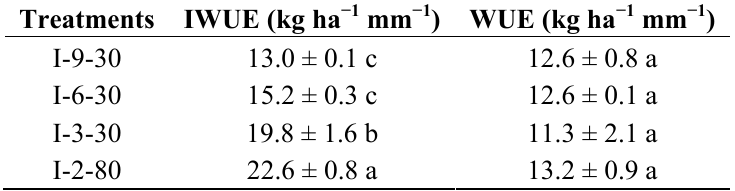
Table 5. Irrigation water use efficiency (IWUE) and water use efficiency (WUE). Means in the same column followed by the same letter are not significantly different at the 0.05